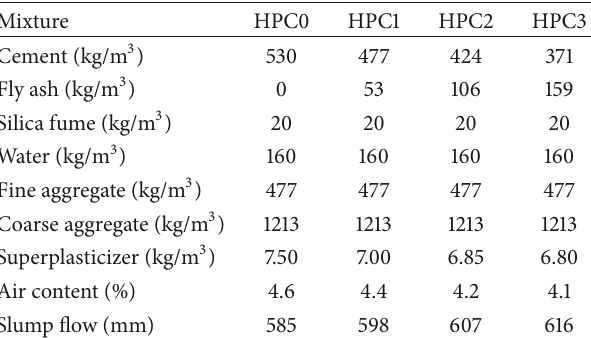
Table 2: Mix proportions and fresh properties of